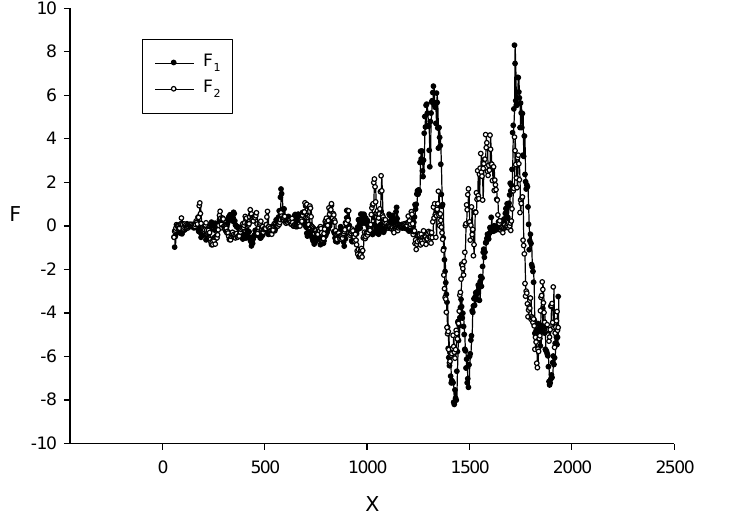
Fig.2. The functions F and F are shown against position x for the sequence YPK_3724 from 1 2 Kegg data bank. This gene codes the amino acid sequence of the DEAD/DEAH box helicase domain protein from a genome of Y.pseudotuberculosis (YPIII). (Swiss-Prot entry is